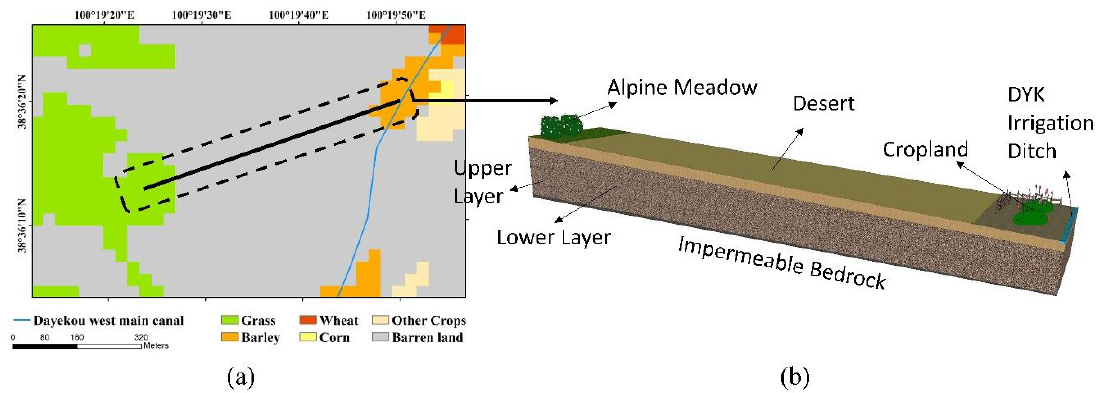
Figure 7. Conceptual model of the DYK case: ( a ) Location; ( b ) Landcover, hydrological and geolog- ical conditions.